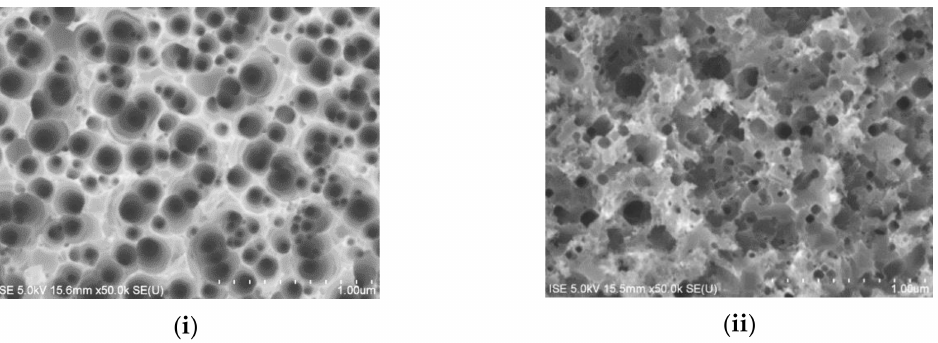
Figure 8. Top-view SEM images of c-Si surfaces etched with σ F = 5% and v = 2 mm / s at T wafer of ( i ) 200 ◦ C, and( ii )300 ◦ C.Themeasuredweightedsurfacereflectionvaluesare R w ≈ 4%( T wafer = 200 ◦ C) and R w ≈ 9% ( T wafer = 300 ◦ C).